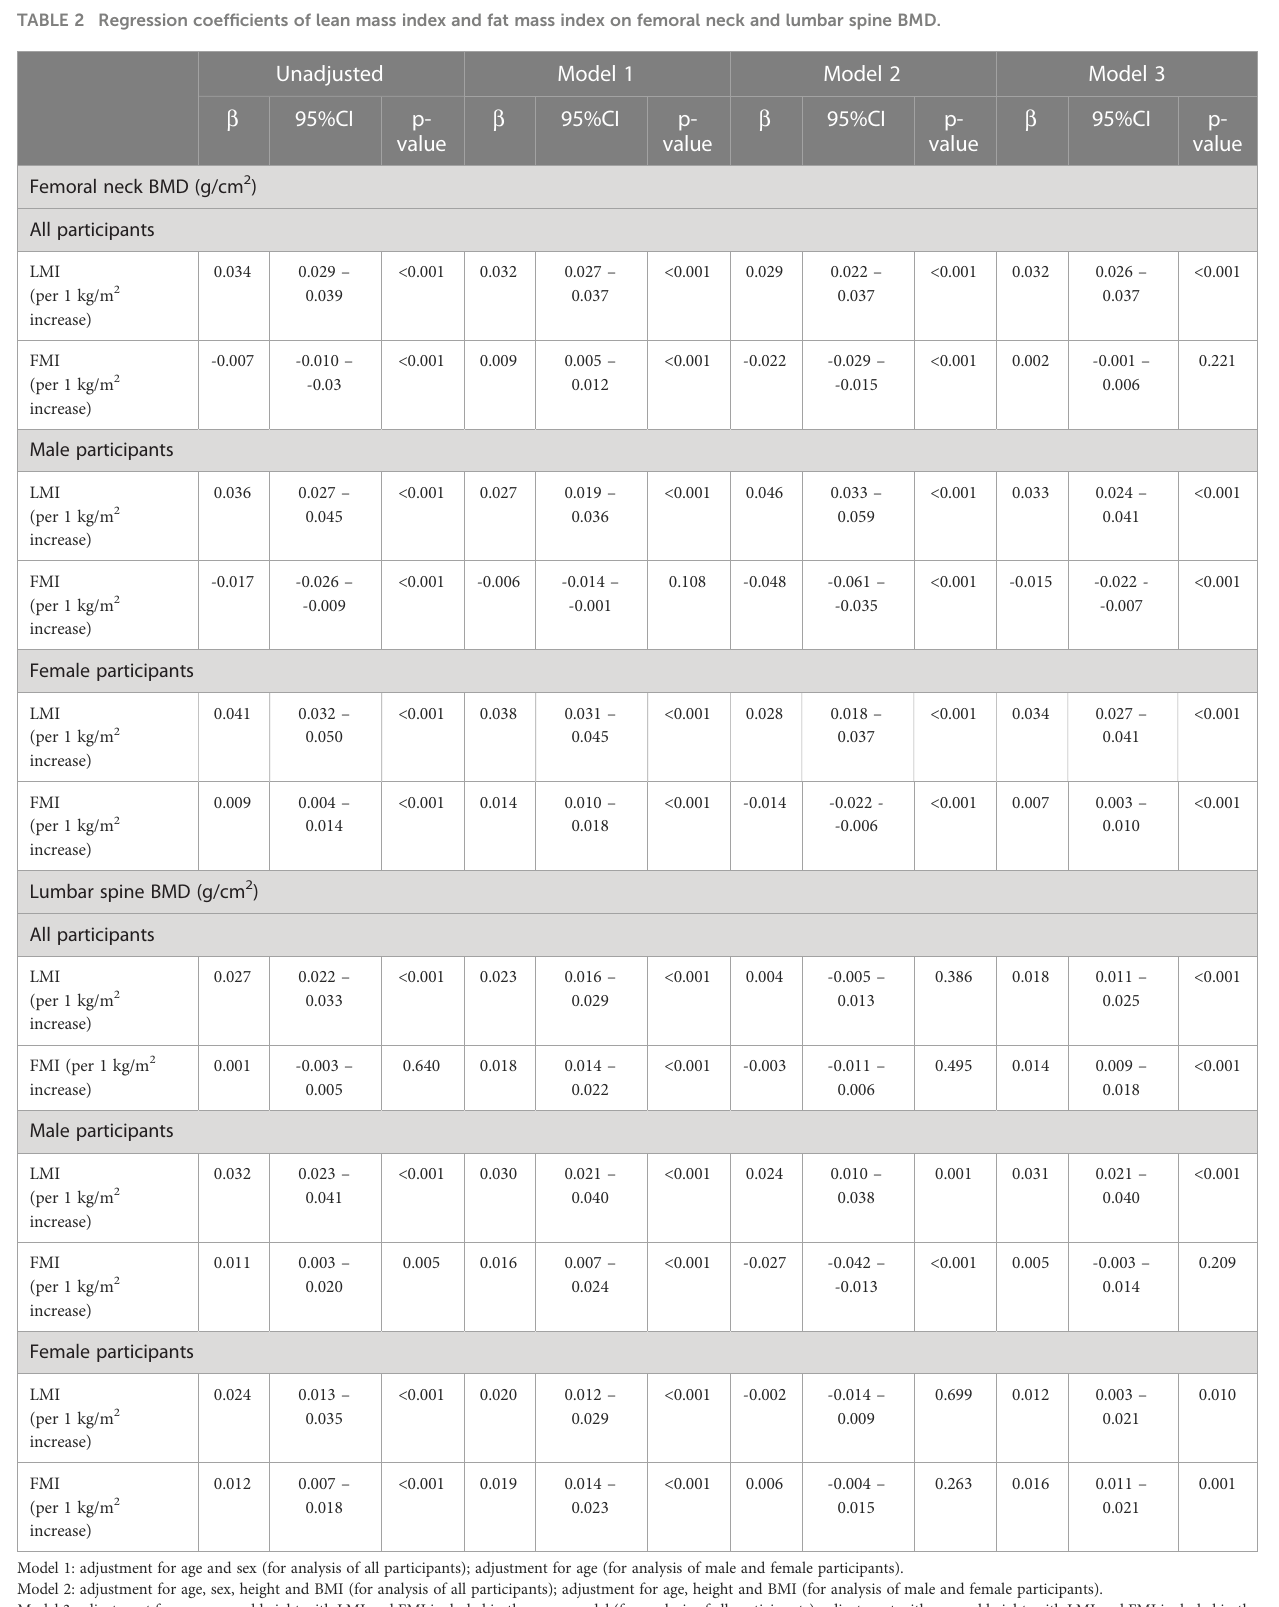
TABLE 2 Regression coef fi cients of lean mass index and fat mass index on femoral neck and lumbar spine BMD.